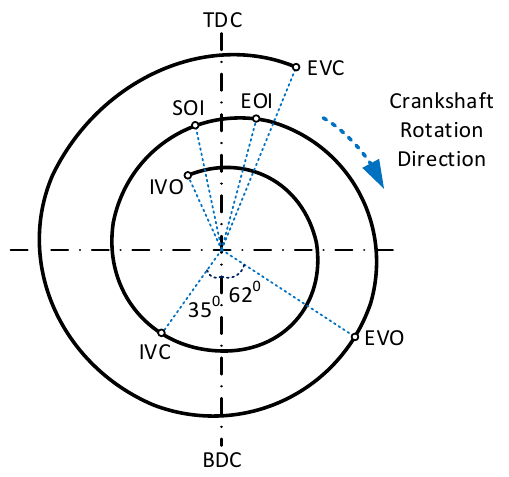
Figure 3. Schematic of the engine working cycle (TDC: Top dead center, BDC: Bottom dead center; IVC: Intake valve closes; EVO: Exhaust valve opens; SOI: Start of injection; EOI: End of injection)